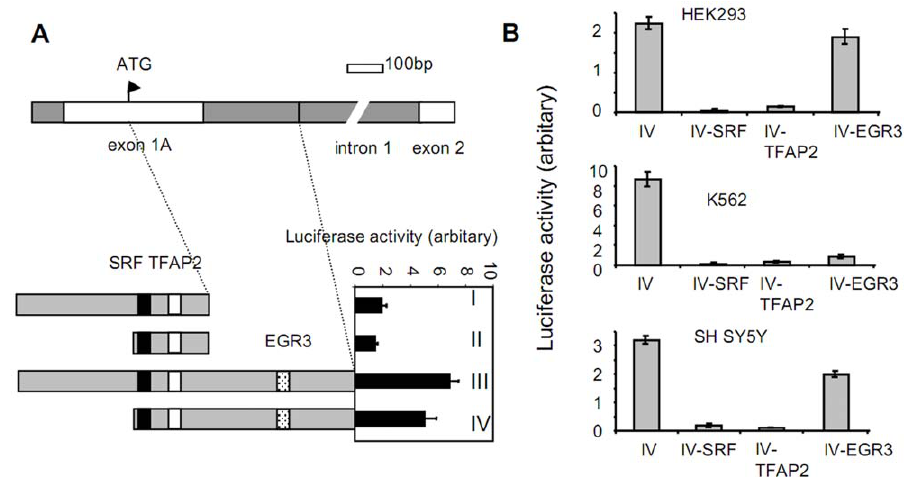
Figure 3. The SRF and TFAP2 binding sites in the FXN promoter are important for frataxin expression. (A) Luciferase analysis of a novel intronic regulatory region of the FXN gene. The upper panel portrays the upstream region of the FXN gene including the exon 1 and 2 and intron 1. Bottom panel: luciferase activity was measured in cells transfected with luciferase constructs containing truncated FXN promoter fragments containing the SRF and TFAP2 binding sites. Filled square: SRF binding site; open square: TFAP2 binding site; dotted square: EGR3 binding site. The four luciferase constructs are designated as I, II, III, IV (see MATERIALS AND METHODS). (B) Mutation of the SRF and TFAP2 binding sites in the FXN promoter dramatically decreased luciferase activity driven from FXN promoter fragment IV. Mutation of the predicted EGR3 transcription factor binding site in intronic sequence of the FXN gene showed cell line-specific effects on transcriptional activity. Three separate experiments were carried out. For each experiment, duplicate transfections were performed. Error bars represent the standard deviation.